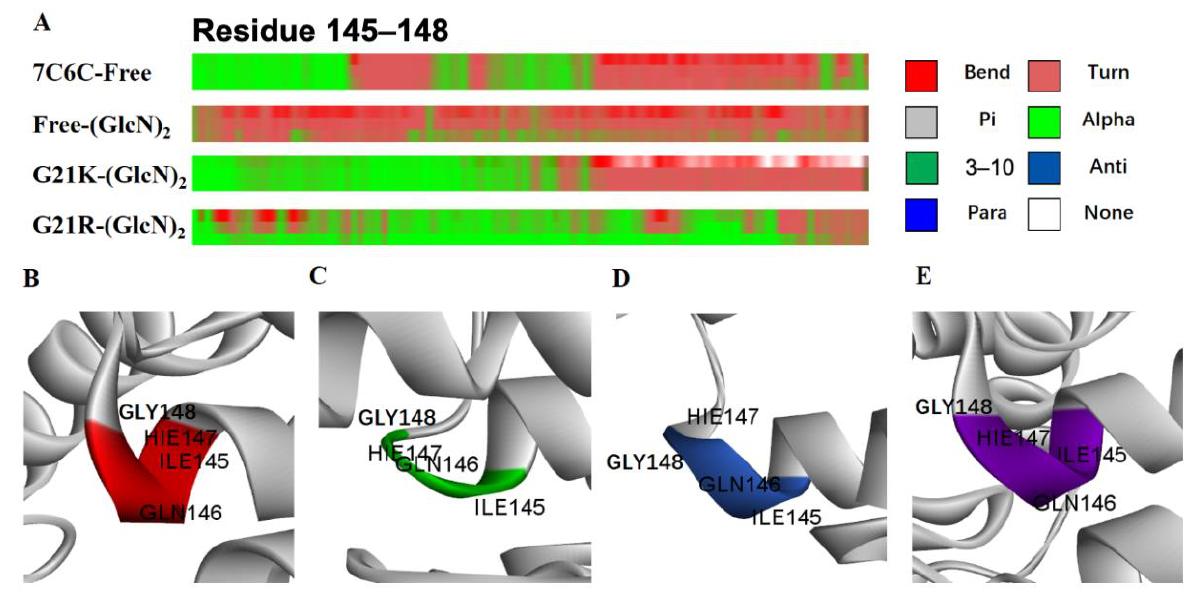
Figure 7. ( A ) Secondary structure changes in residues Ile145-Gly148; ( B ) 7C6C-free; ( C ) 7C6C-(GlcN) 2 ; ( D ) G21K-(GlcN) 2 ; ( E ) G21R-(GlcN) 2 .